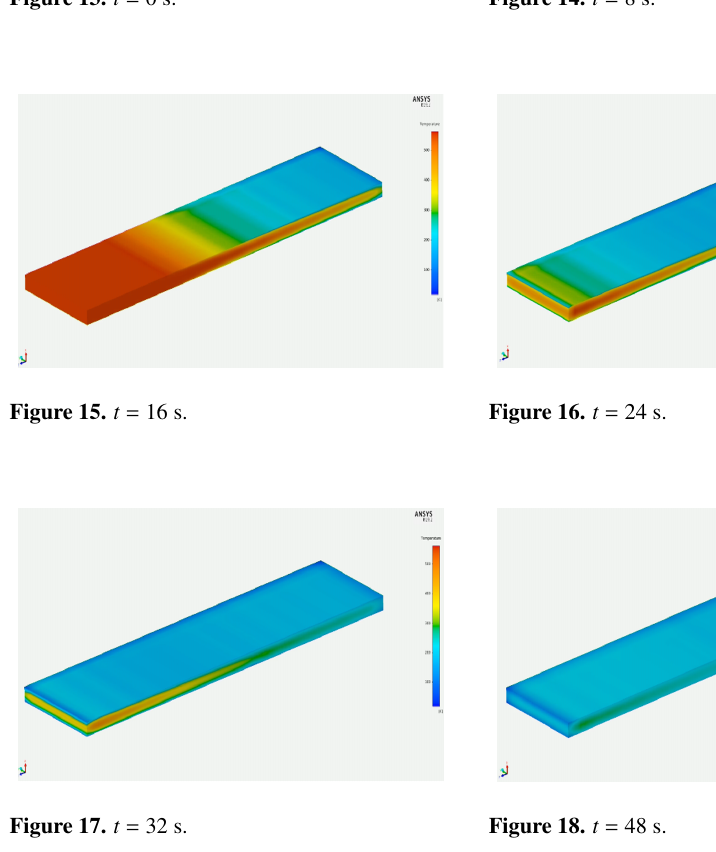
Figure 13. t = 0 s. Figure 14. t = 8 s.